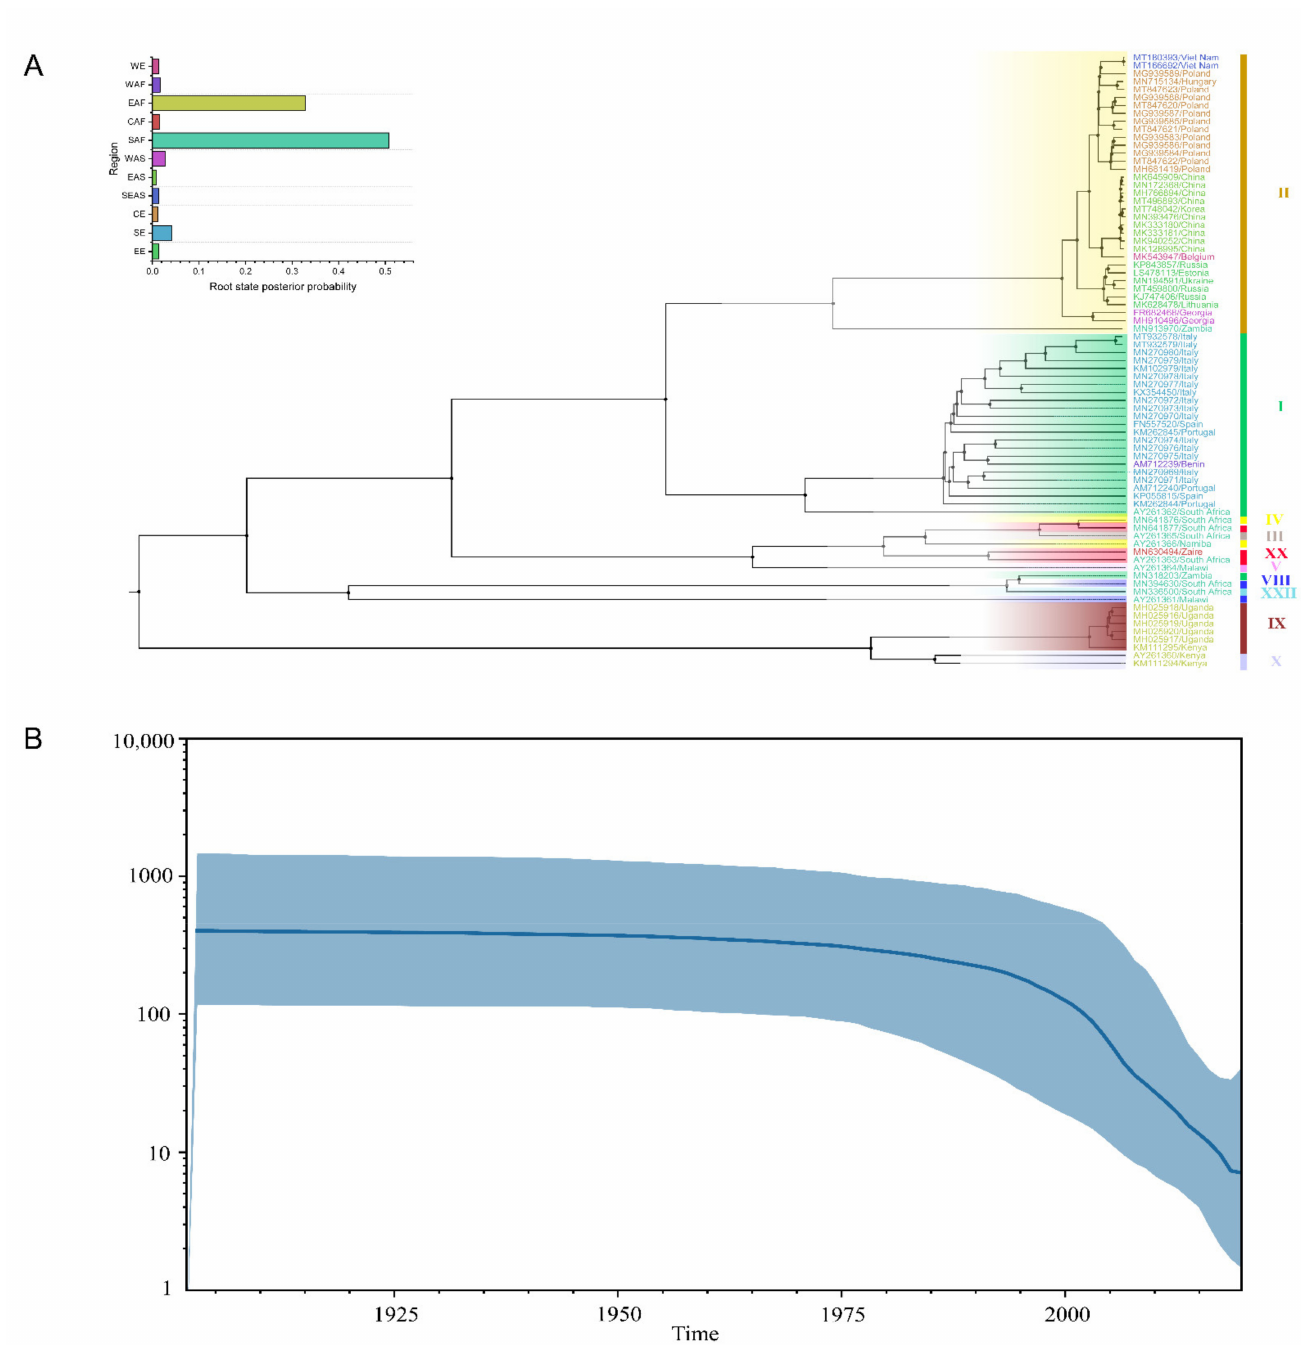
Figure 2. Bayesian phylodynamic analysis of ASFV: ( A ) maximum clade credibility tree of the E183L gene of ASFV; different colors indicate the virus location—the histogram represents the posterior probability of the root state in the MCC tree; ( B ) Bayesian skyline plot showing the population size in time for worldwide ASFV. The y-axis represents the effective population size (Ne) and the virus generation time ( τ ). The x-axis reports the time. The dark blue line shows the median estimate of the population size, and the light blue shading shows the 95% credibility